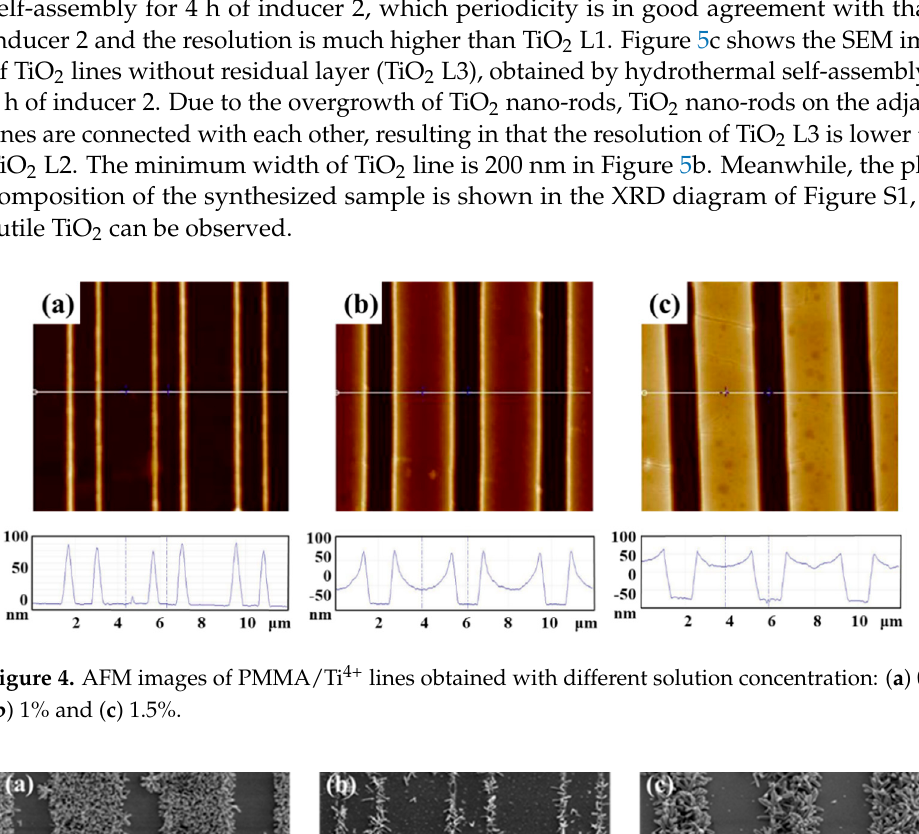
Figure 4. AFM images of PMMA/Ti 4+ lines obtained with different solution concentration: ( a ) 0.5%, ( b ) 1% and ( c ) 1.5%.